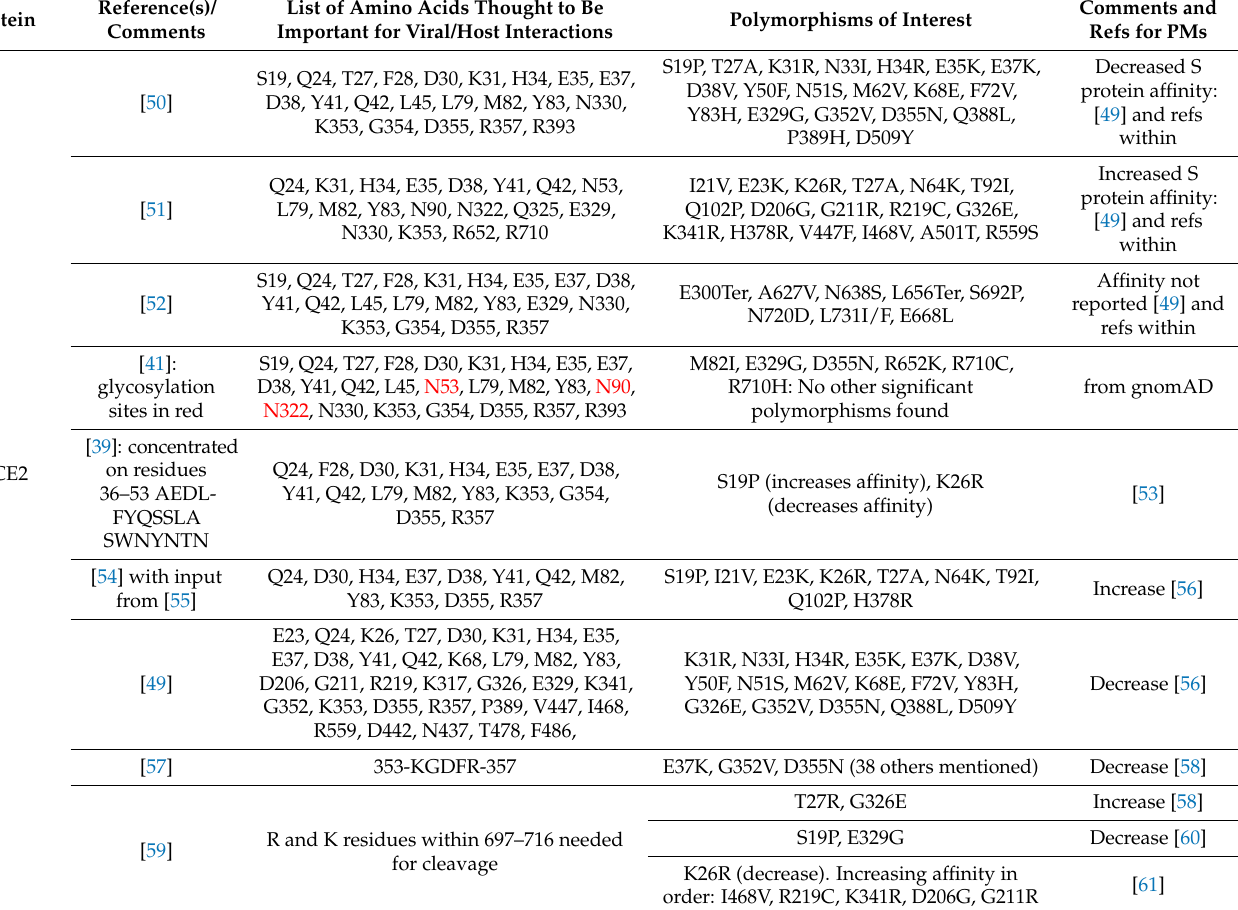
Table 2. Amino acids deemed to be important in selected proteins and polymorphisms which have been found to be significant. Glycosylated residues highlighted in red. Note: Senapati et al. [49] is a preprint at the time of writing this